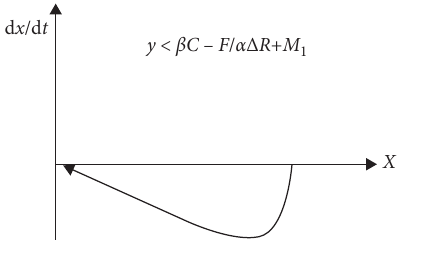
Figure 3: Stable solution for y < (( β C − F ) / ( α Δ R + M